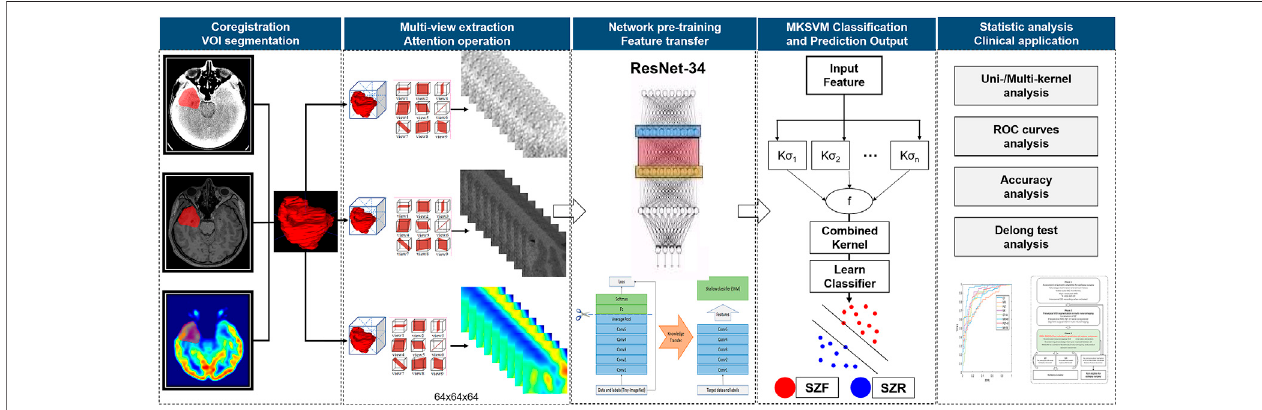
FIGURE 3 | Flowchart of algorithm. Manually segment target volume of interest (VOI) in multimodal neuroimaging. Then, automatically extract multi-view slice of each modal VOI, transfer and fuse features using a well-trained deep residual network (ResNet-34, DRN) and multi-kernel support vector machine (MKSVM) to provide individualizedpredictionsofseizureoutcomes afterepilepsysurgery.Afterthat,classi fi cationperformanceofdifferentmethodswasevaluatedbyquantitative measures, including accuracy, sensitivity, speci fi city, and area under receiver operating characteristic curve. Differences between various areas under receiver operating characteristic curve were compared using a Delong test. Abbreviations: SZF, seizure-free (Engel class I); SZR, seizure recurrence (Engel class II through IV).